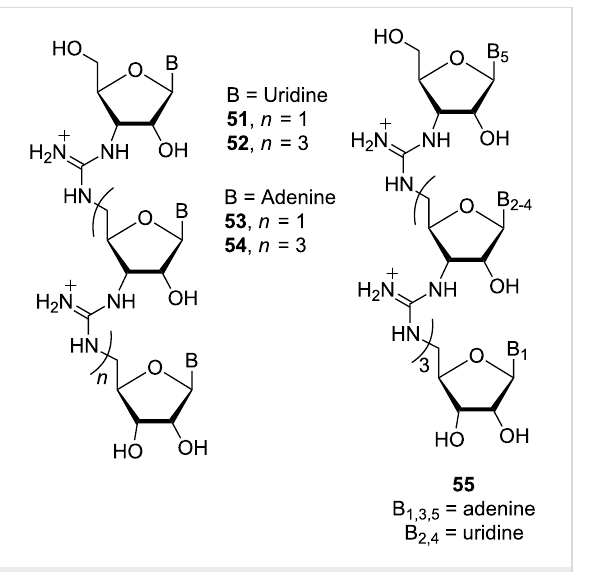
Figure 23: Structures of the homo-oligomeric RNG derivatives 51 – 55 .